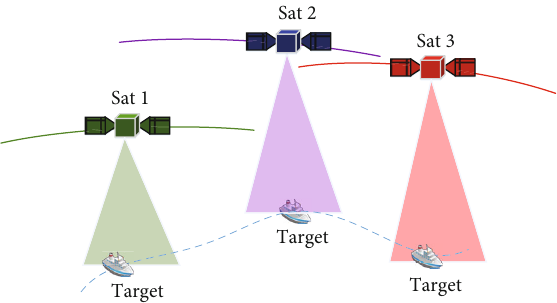
Figure 2: Moving target tracking task mode scheme.